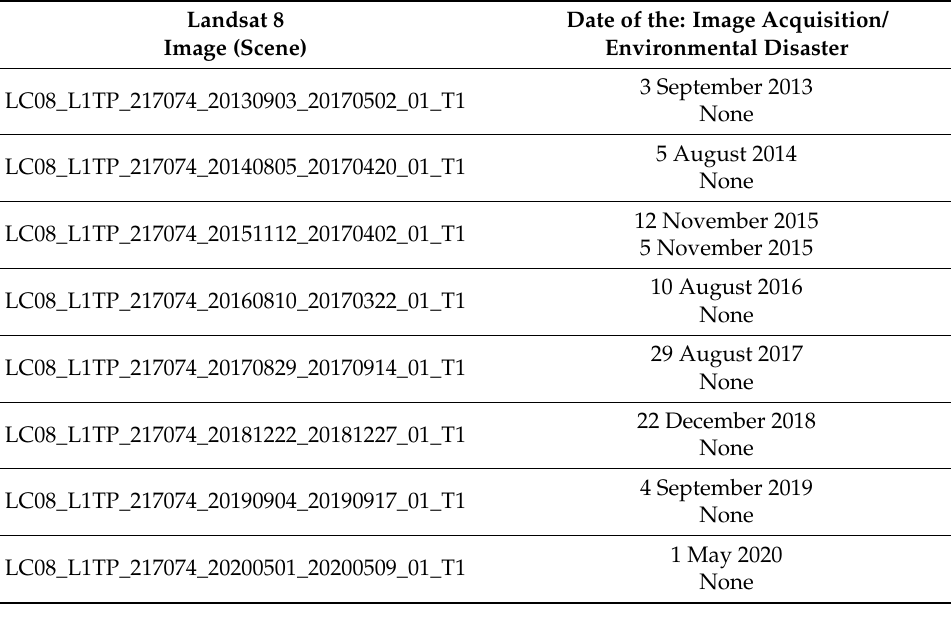
Table 2. Information about the time series images. Information in the first column refers to Landsat 8 OLI (Operational Land Imager) and TIRS (Thermal Infrared Sensor) Collection 1 Level-1 Data Products [50]. In the second column, the word ‘none’ refers to the absence of any environmental disaster at the respective date.